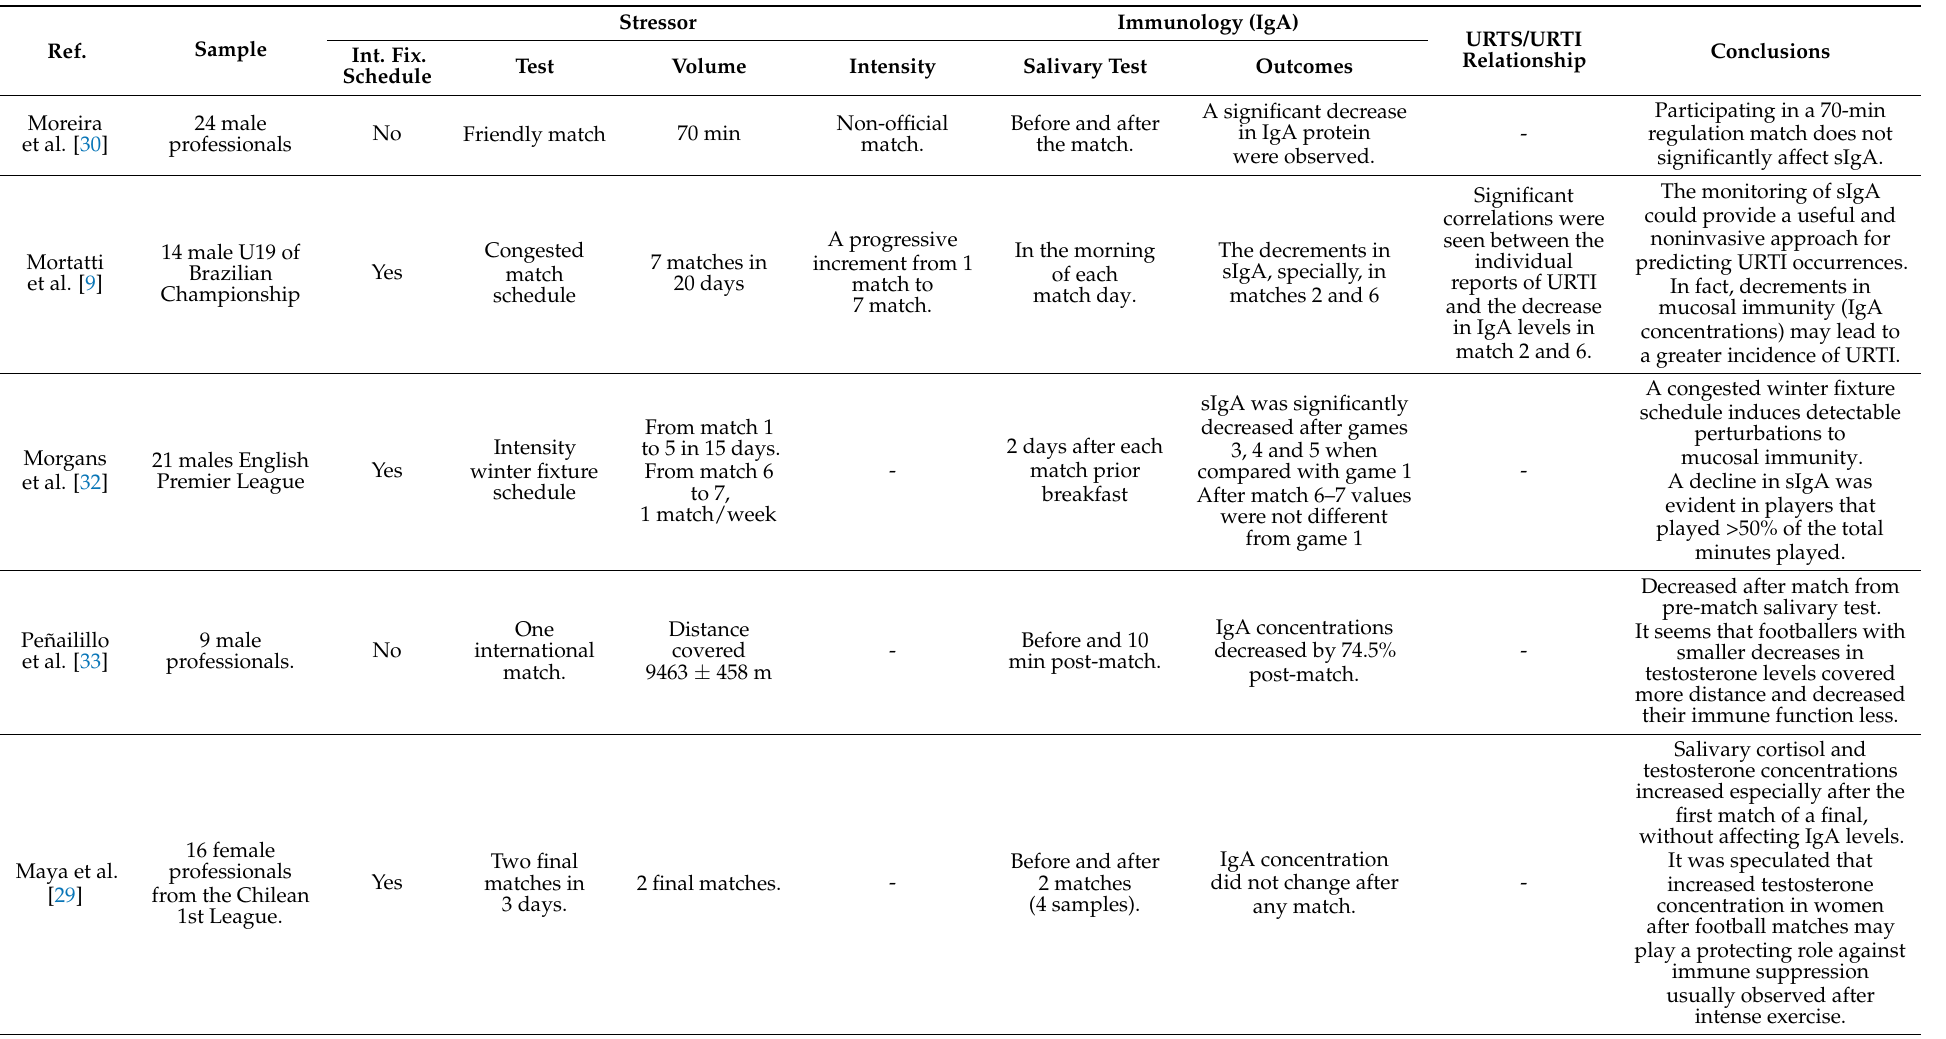
Table 1. Immunoglobulin A responses considering matches as a stressor during intensive or non-intensive fixture